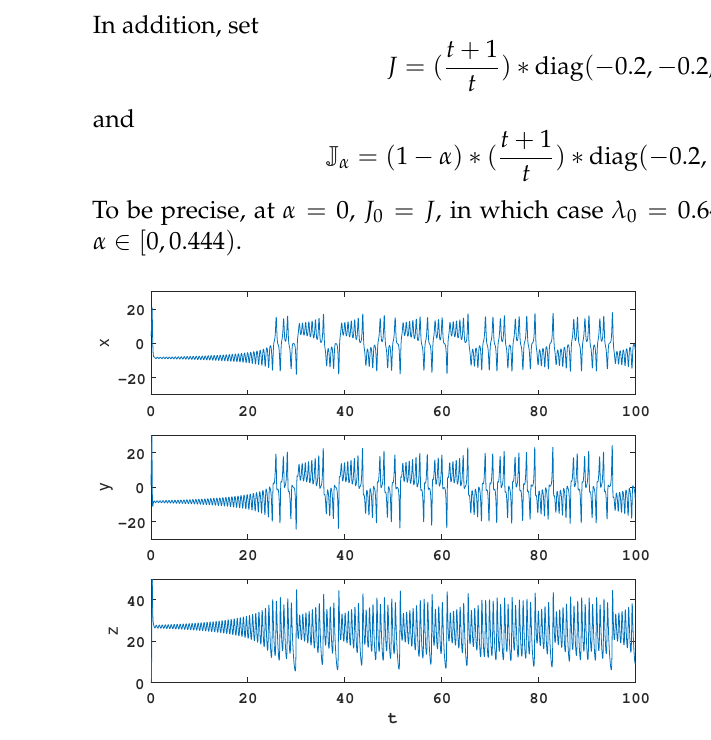
Figure 2. The chaos diagram of Lorenz’s system at initial condition x 0 = [ 5,1, − 3 ] T . So, at α = 0.4, J 0.4 = 0.6 ∗ ( t + 1 and the response curve is in Figure 3.